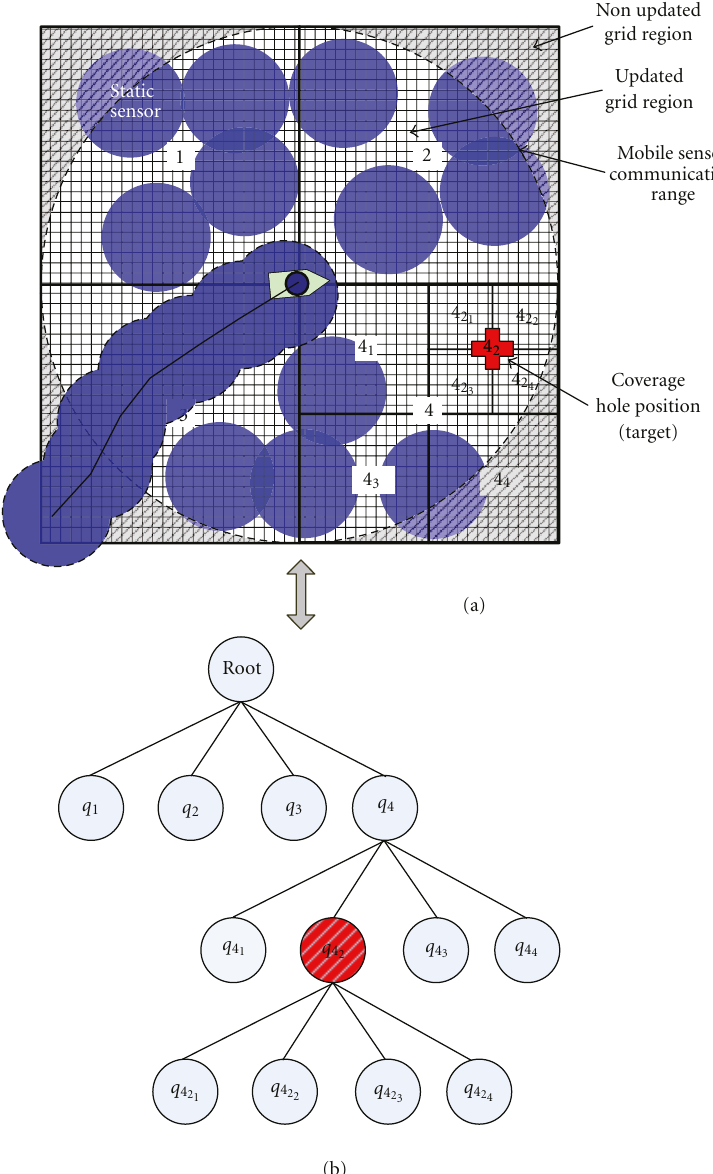
Figure 4: Illustration of the zoom algorithm (a) Grid segmentation (b) Generated